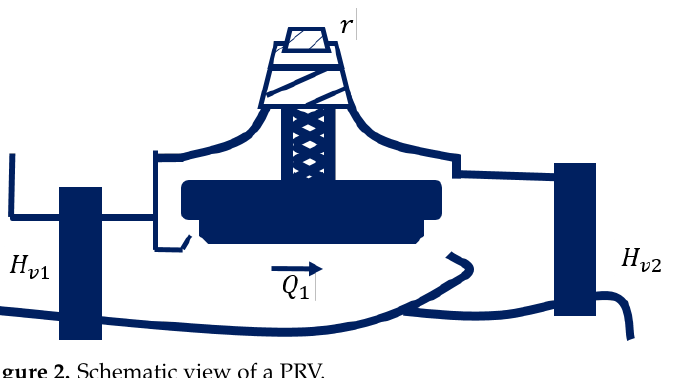
Figure 2. Schematic view of a PRV.